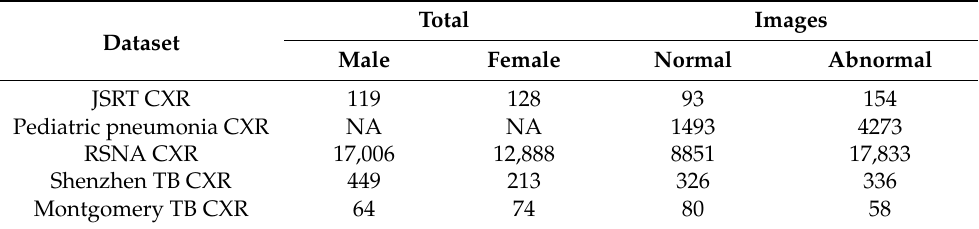
Table 1. Demographic study. Details including patient count, sex, and the count of abnormal and normal images available for various datasets used in this study are shown. NA denotes Not Available. A total of 33,497 CXRs are included. Of these, 22,654 are abnormal with 394 being positive for TB (1.74% of abnormals, 1.18% of the entire